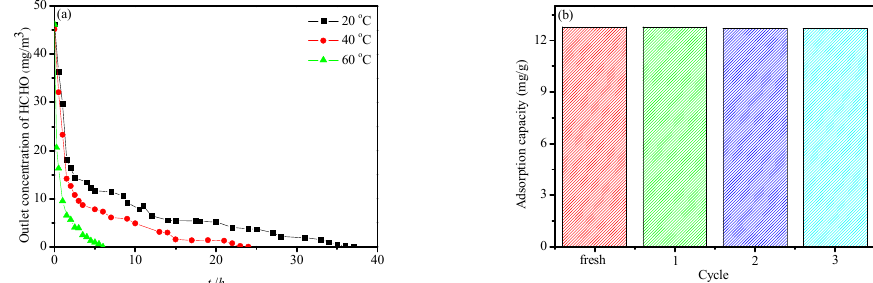
Figure 9. ( a ) Effects of temperature on HCHO desorption from CGC by 100 mL/min N 2 flow; and, ( b ) Cyclic stability of HCHO adsorption on CGC with adsorption conditions: 0.5 g CGC, 20 °C, 28 mL/min, C inlet = 39.2 mg/m 3 , RH = 40%.